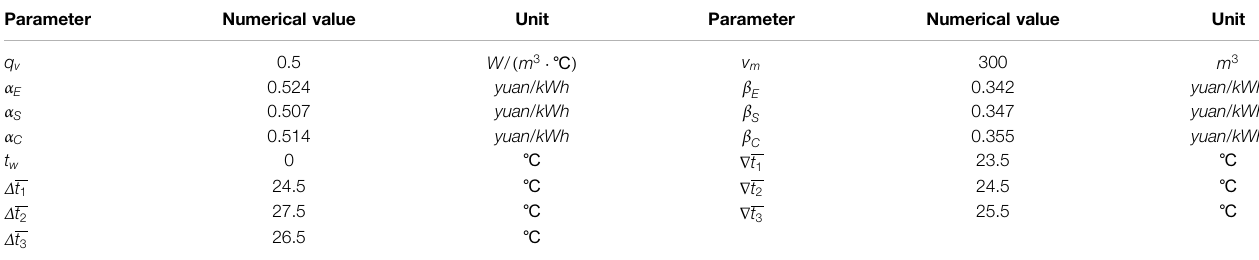
TABLE 1 | Calculation parameter table.